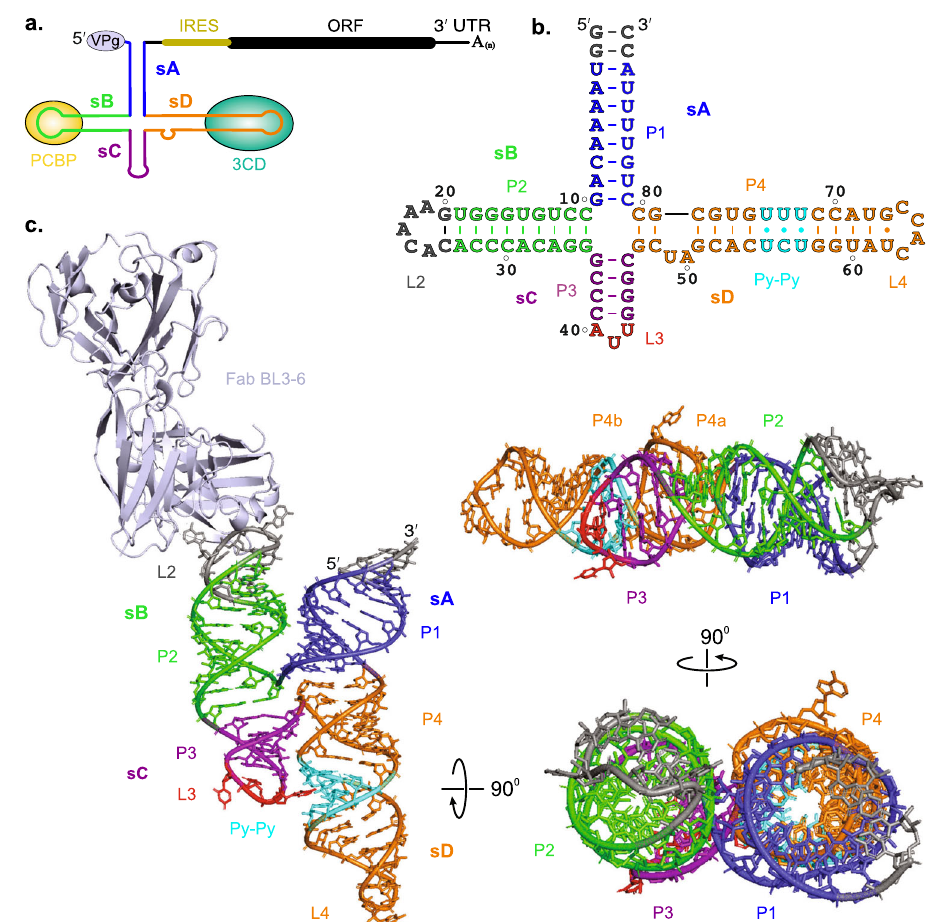
Fig. 1 | Enteroviral genome organization and overall structure of CVB3 5 ′ CL in complex with Fab BL3-6. a Schematic of an enterovirus genome depicting the location of the 5 ′ CL and its proposed secondary structure with putative binding sites for viral 3CD and host PCBP proteins. b Secondary structure of CVB3 5 ′ CL2a crystallization construct based on previous biochemical analysis, where the Fab BL3-6bindingepitope5 ′ -GAAACAC-3 ′ motifreplacestheL2loopof thesubdomain